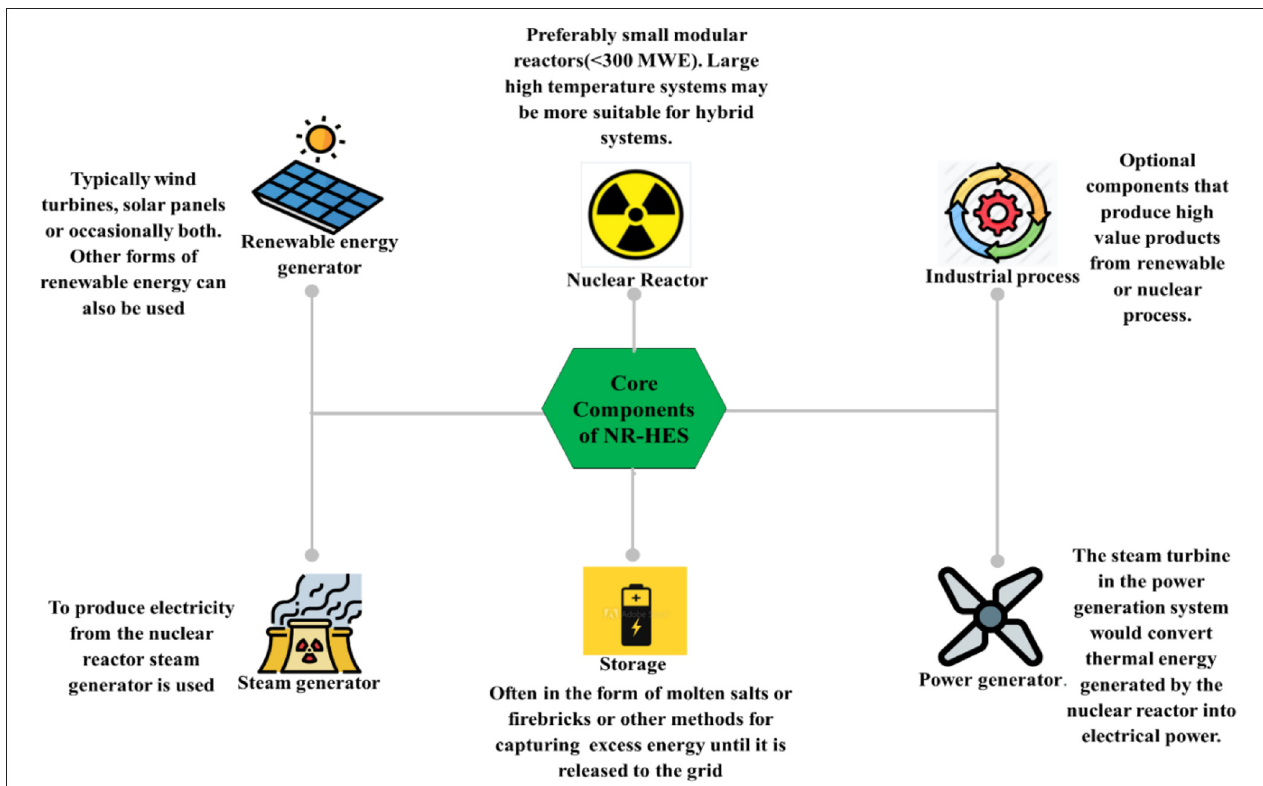
FIGURE 2 | Core components of a